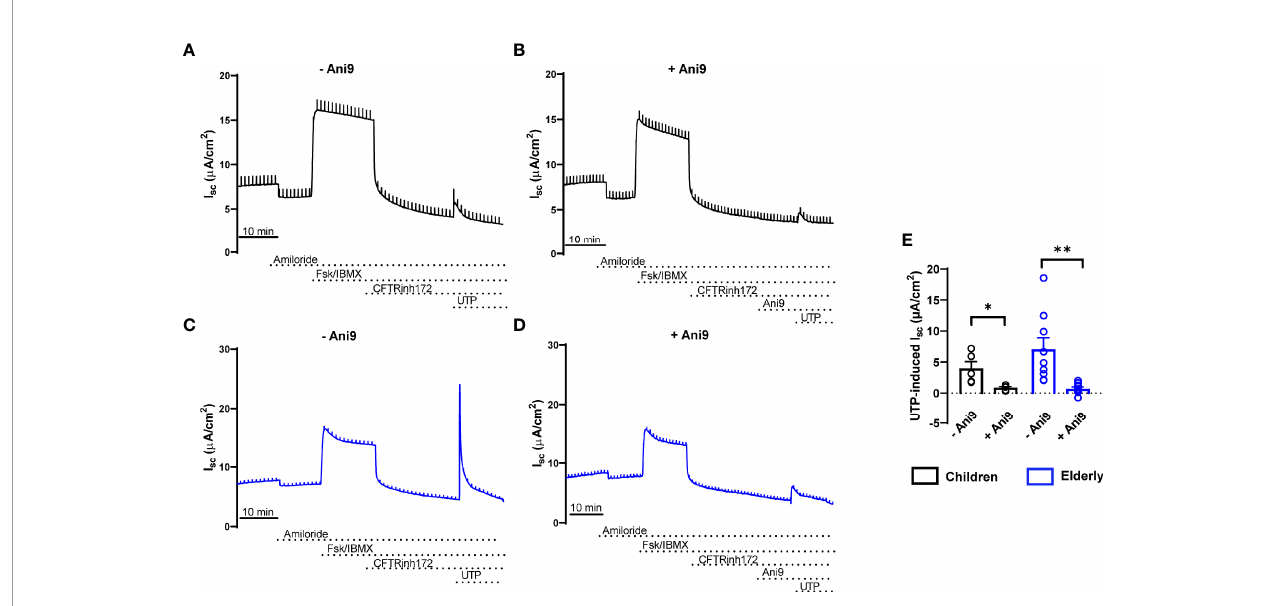
FIGURE 3 | Age-related differences in calcium-activated chloride secretion in nasal epithelial cultures are mediated by TMEM16A. (A – E) Representative original recordings and summary data of transepithelial Ussing chamber measurements in primary nasal epithelial cultures from healthy children (A, B, E) and elderly people (C – E) showing the effect of UTP-induced I sc in the absence (A, C, E) and presence (B, D, E) of the TMEM16A inhibitor Ani9 ( n = 4 and 9 individuals per group, data represent mean values of 2 – 3 fi lters per individual). * p < 0.05 and ** p < 0.01 compared to Ani9- group. Data are shown as mean±S.E.M. Statistical analysis was performed with paired two-tailed t test in (E)